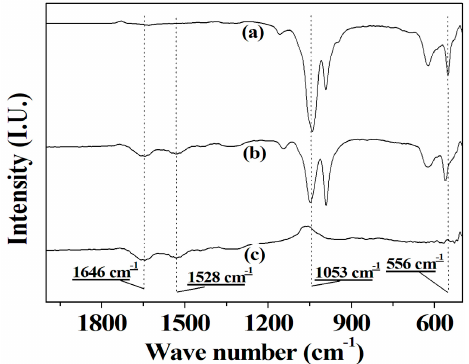
Figure 2. FTIR spectra of Cu 3 (PO) 4 crystal ( a ), co-immobilized tri-enzymes ( b ) and tri-enzymes ( c ).